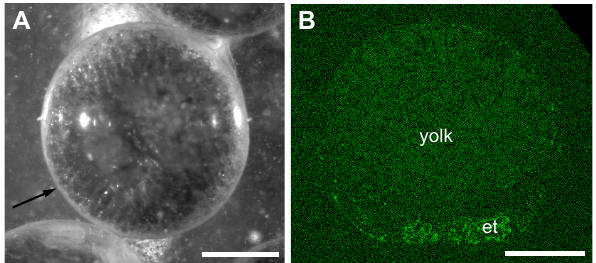
Fig. 3. (A) Photomicrograph of fresh egg of the marbled cray- fish Procambarus fallax f. virginalis . Black arrow points to the translucent endochorion covering the yolk and the embryonic tis- sue. (B) SEM X-ray mapping of P of a sliced untreated crayfish egg illustrating the original uniform P distribution for the yolk, whereas the embryonic tissue (et) of the germ area shows elevated P content (scale bar: A =500µm; B